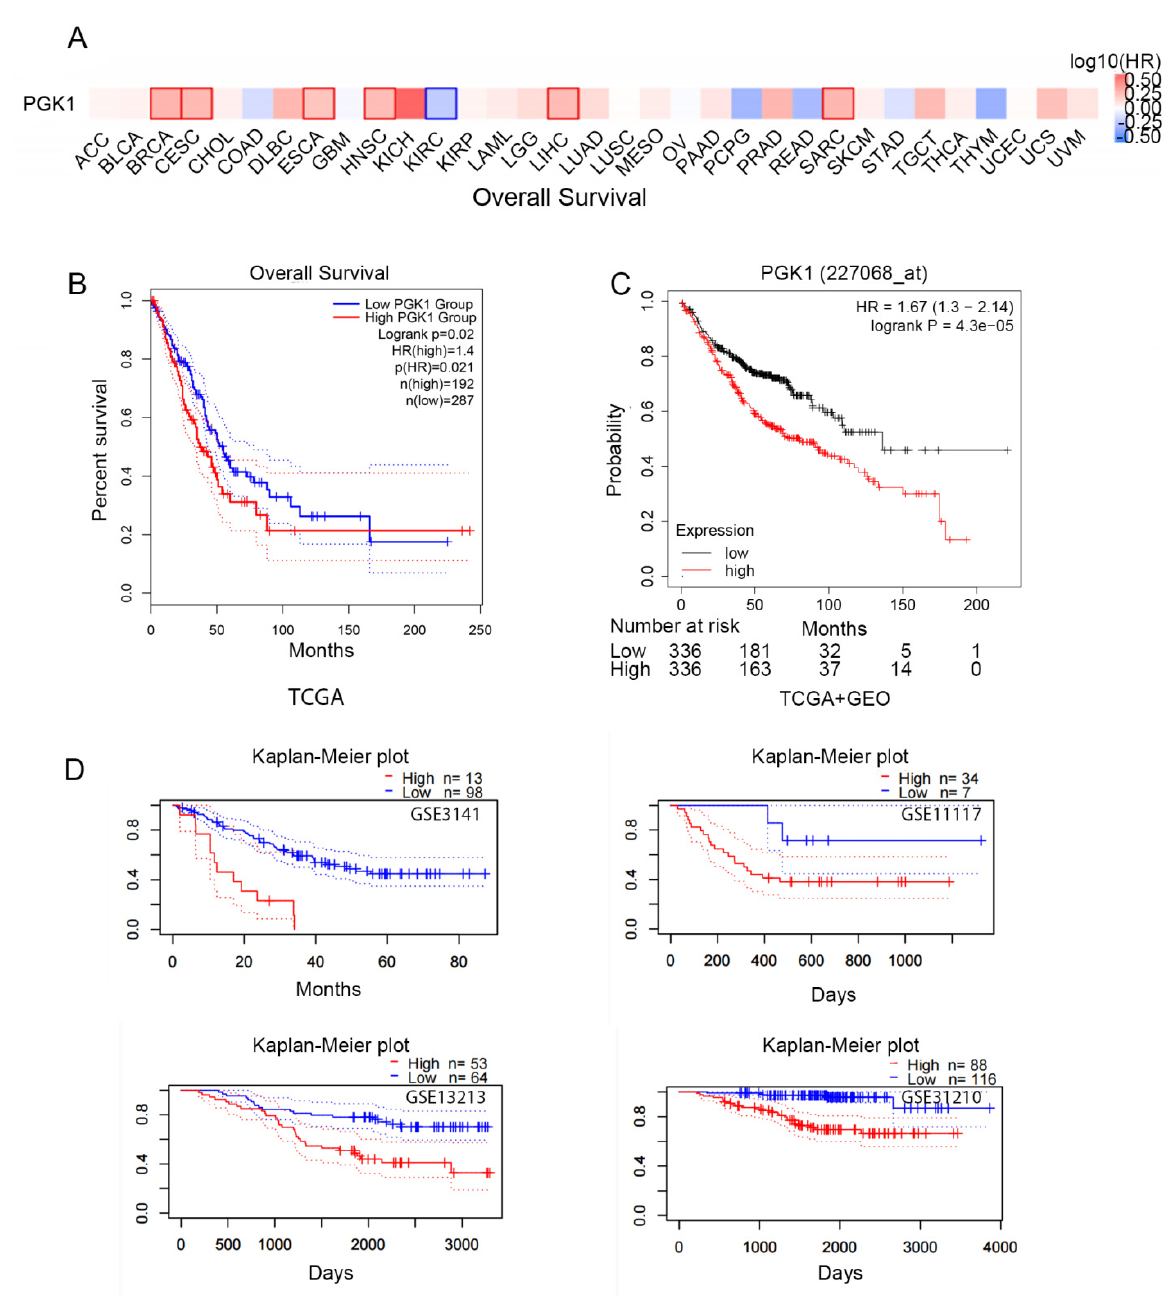
Figure 2. Prognostic value of the mRNA expression of PGK1. ( A ) Relationship between the expression of PGK1 and pan-cancer overall survival (OS) from TCGA database. ( B ) Prognostic value of the mRNA expression of PGK1 in LUAD from TCGA database (GEPIA2.0). ( C ) The Kaplan–Meier curve of PGK1 LUAD obtained from integrated data of TCGA and GEO (Kaplan–Meier plotter). ( D ) The poor prognostic value of PGK1 expression in LUAD obtained from the GEO database (PrognoScan).